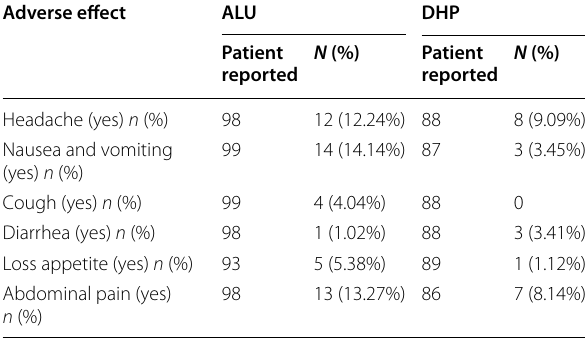
Table 4 Patient-reported adverse